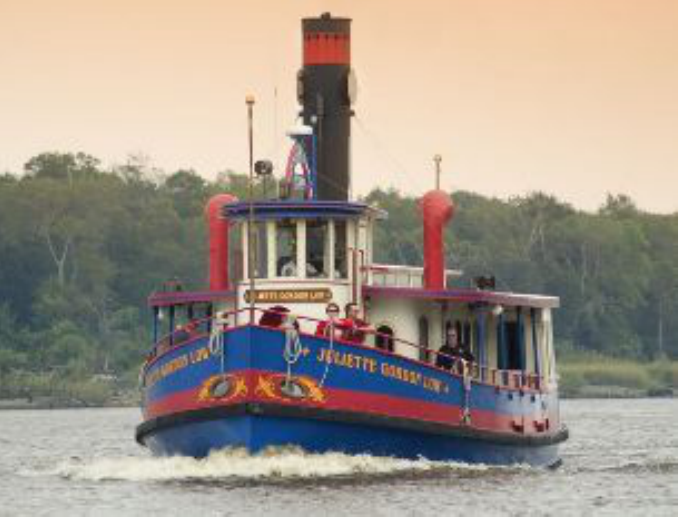
Figure 3. Savannah Belle Ferry (Juliette Gordon Low boat)